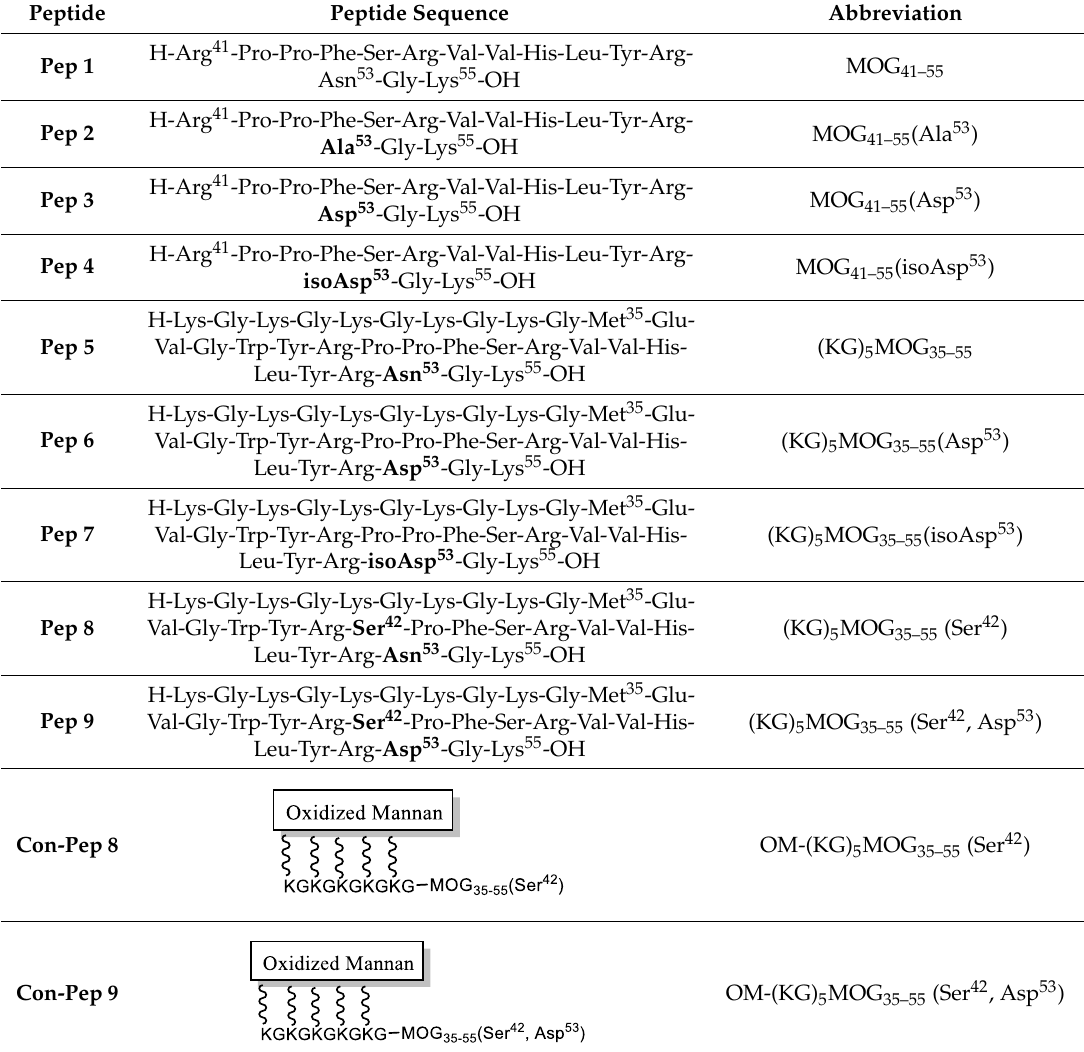
Table 1. Sequence of studied peptides.